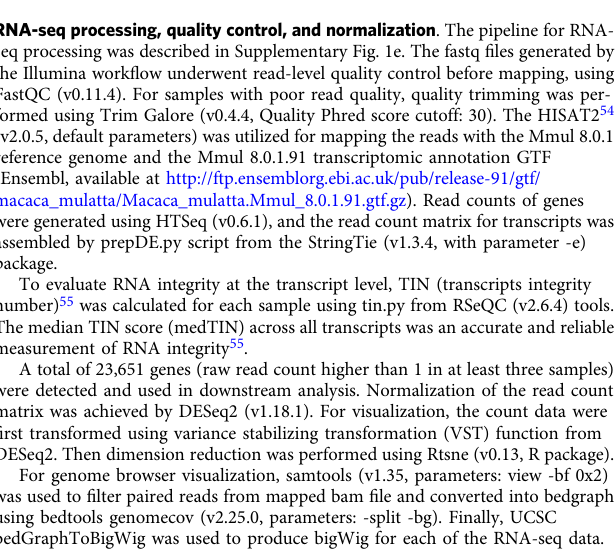
Fig. 5 Differential analysis of chromatin accessibility. a Accumulated barplot showing the feature distribution of reproducible peaks and consensus peaks of all six regions (reproducible X means peak found in X regions). b Heatmaps depicting enriched ATAC-seq signal around cornu Ammonis 1 (CA1)- posterior cingular gyrus (PCG) differential peaks in CA1, PCG and other cortical regions. At the top, the enriched lines showing mean values of ATAC-seq signals around the differential peaks (CA1-open and PCG-open) in CA1, PCG and other cortical regions. c Pie charts showing the counts of CA1-open peaks (left) and consensus peaks (right) overlapping with known subcortical enhancers. d Pie charts showing the counts of PCG-open peaks (left) and consensus peaks (right) overlapping with known cortical enhancers. e Barplot showing the function enrichment of the genes correlated with the CA1-open peaks (left) and PCG-open peaks (right) (Pearson ’ s r > 0.7, FDR < 0.1). f Genome browser view showing ATAC-seq signal and RNA-seq expression pro fi les around the NEUROD1 loci. The orange shadow represented the CA1-open peak that was correlated with the NEUROD1 expression. g Genome browser view showing ATAC-seq signal and RNA-seq expression pro fi les around the MCHR2 loci. The orange shadow represented the PCG-open peak that was correlated with the MCHR2